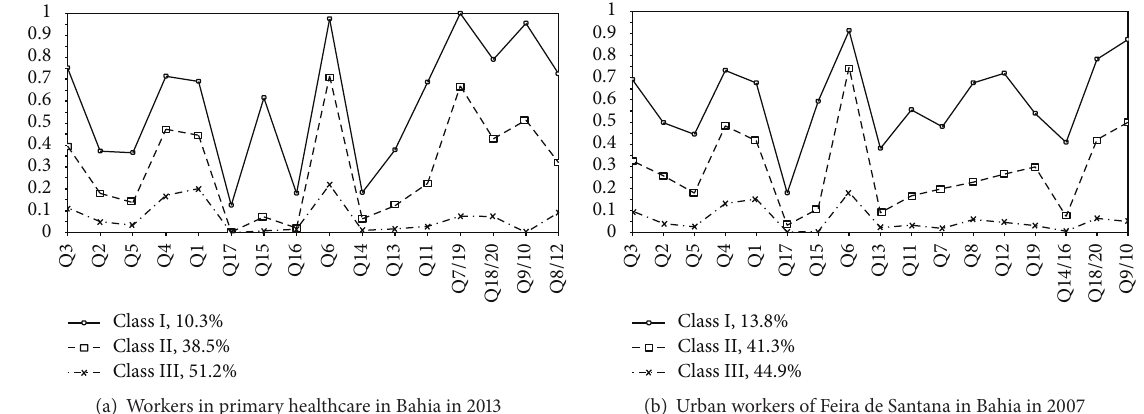
Figure 2: Conditional probability of positive responses to SRQ-20 items according to latent class analysis between healthcare workers